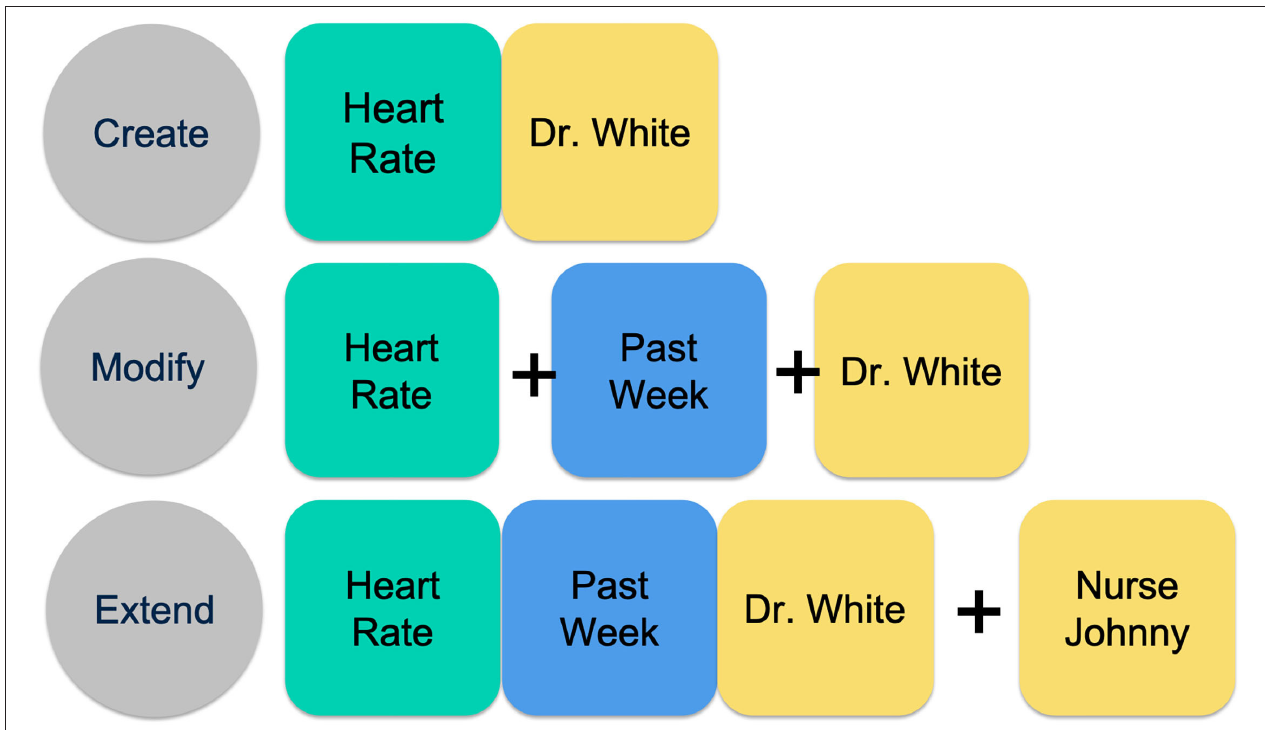
FIGURE 4 | DC supports three basic operations that make it easy to specify and reuse sharing settings: create (top), modify (middle), and extend